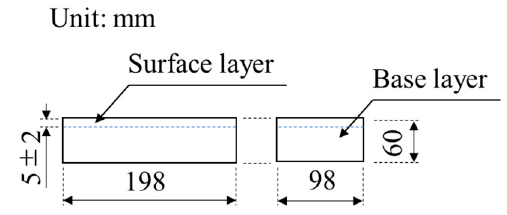
Figure 2. Outline of specimens.